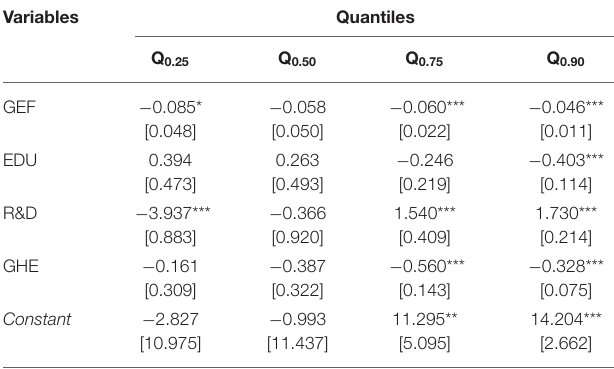
TABLE 8 | Estimates of quantile regression Model 1.